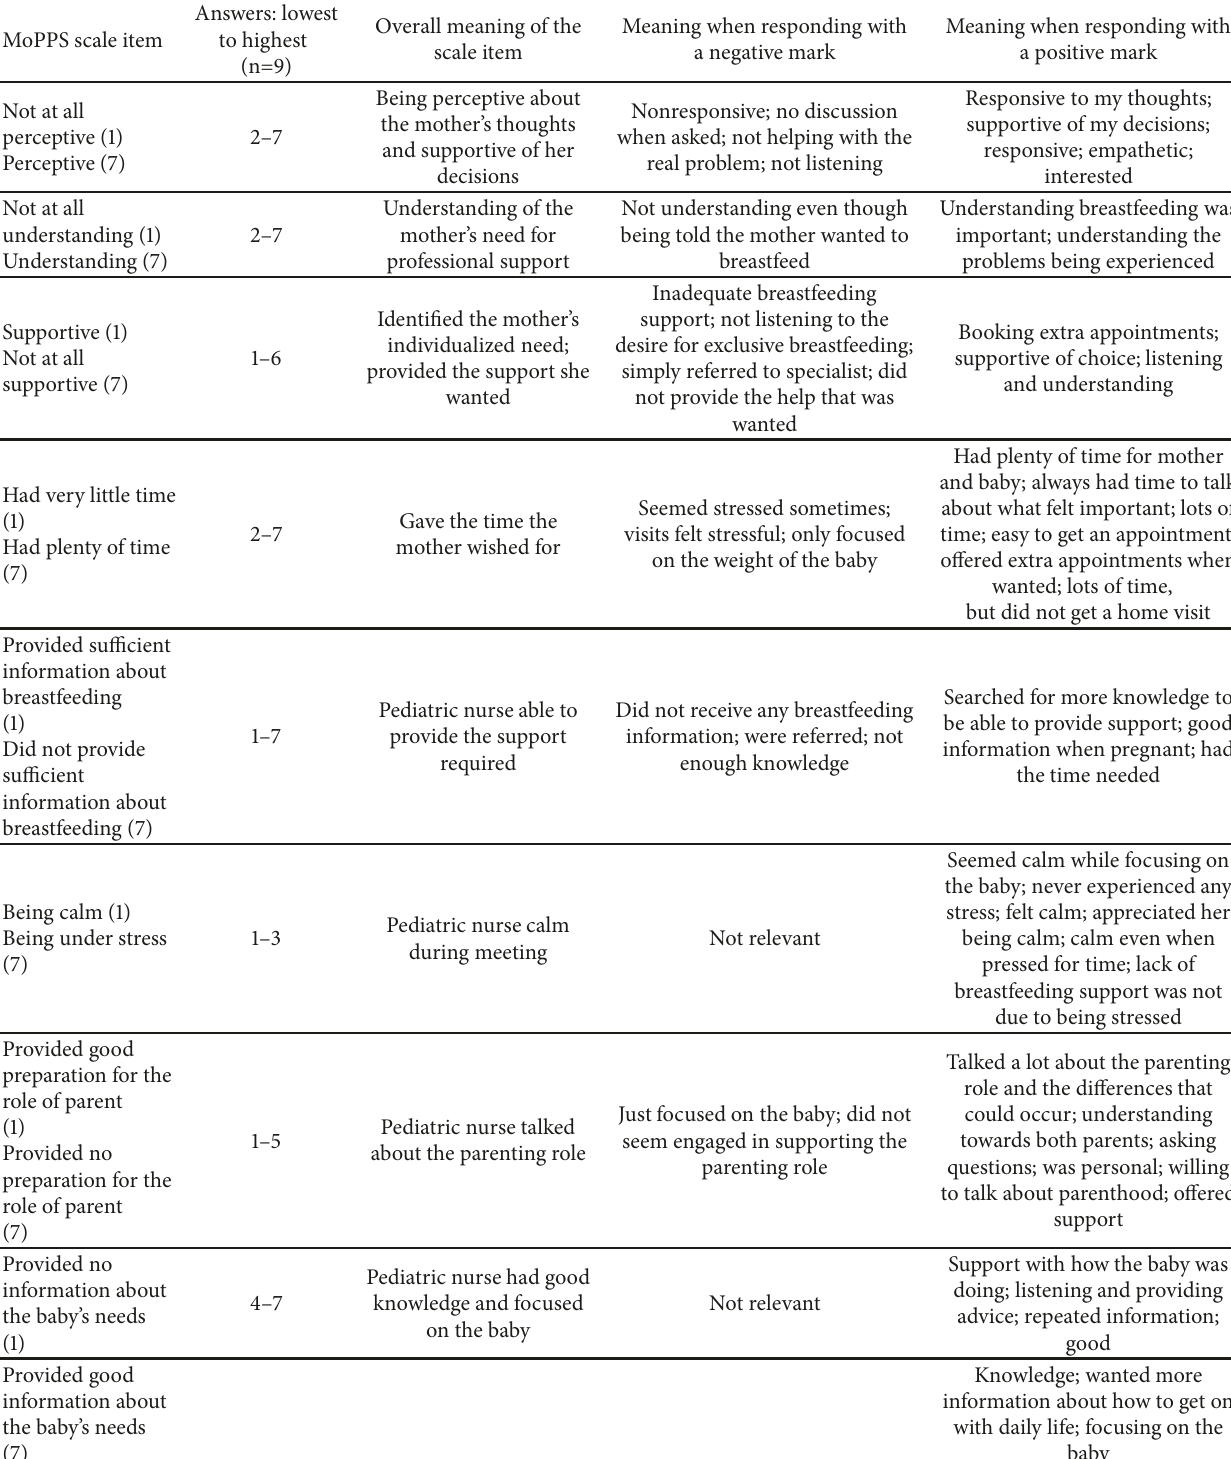
Table 3: Assessment of the MoPPS